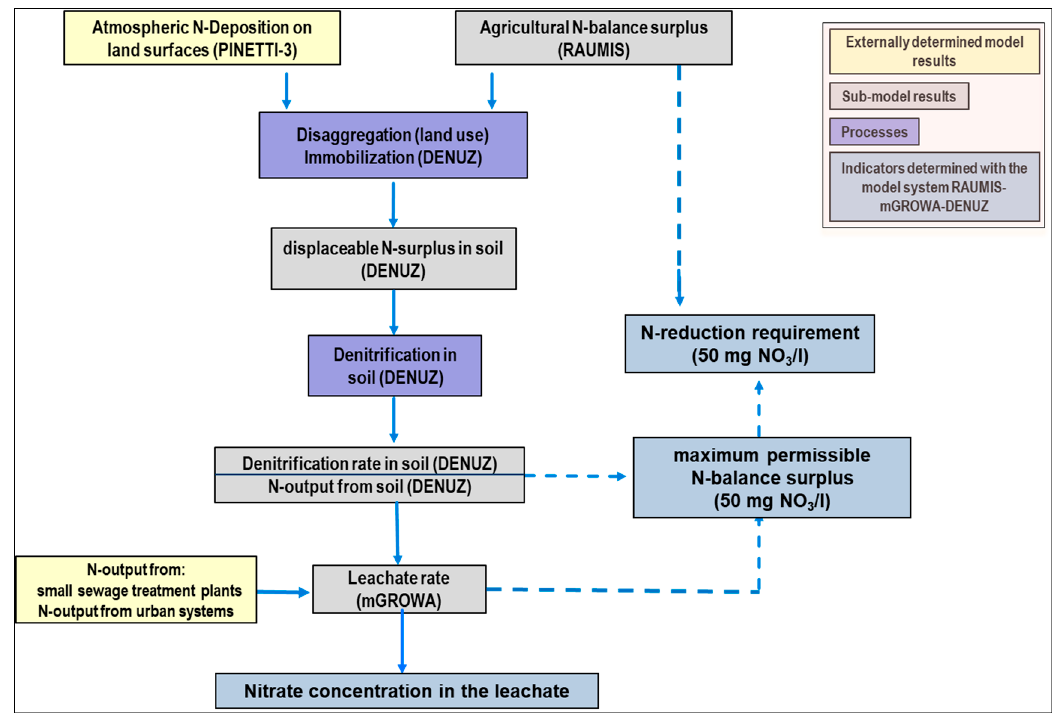
Figure 1. Schematic representation of the model system for deriving nitrate concentration in leachate and related param ‐ eters.